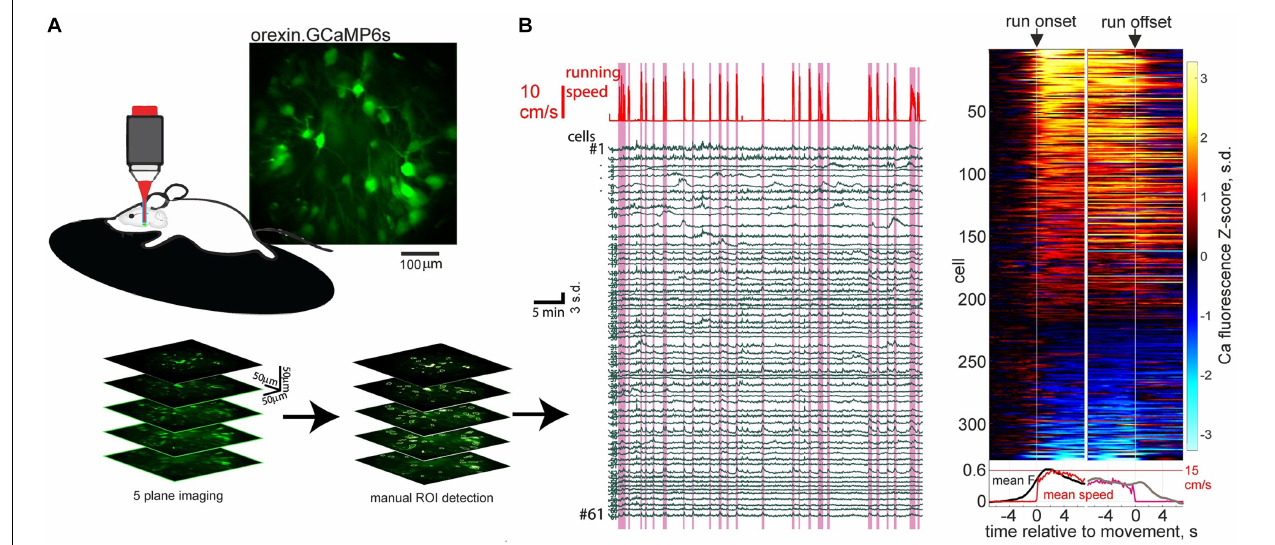
FIGURE 1 | Orexin neural ensemble dynamics underlying running initiation. (A) 2-photon volumetric imaging of multiple orexin neurons in head-fixed mice running on a treadmill. (B) Orexin cell activity profiles aligned to onset and offset of self-initiated running bouts. Source: Karnani et al. (2020).